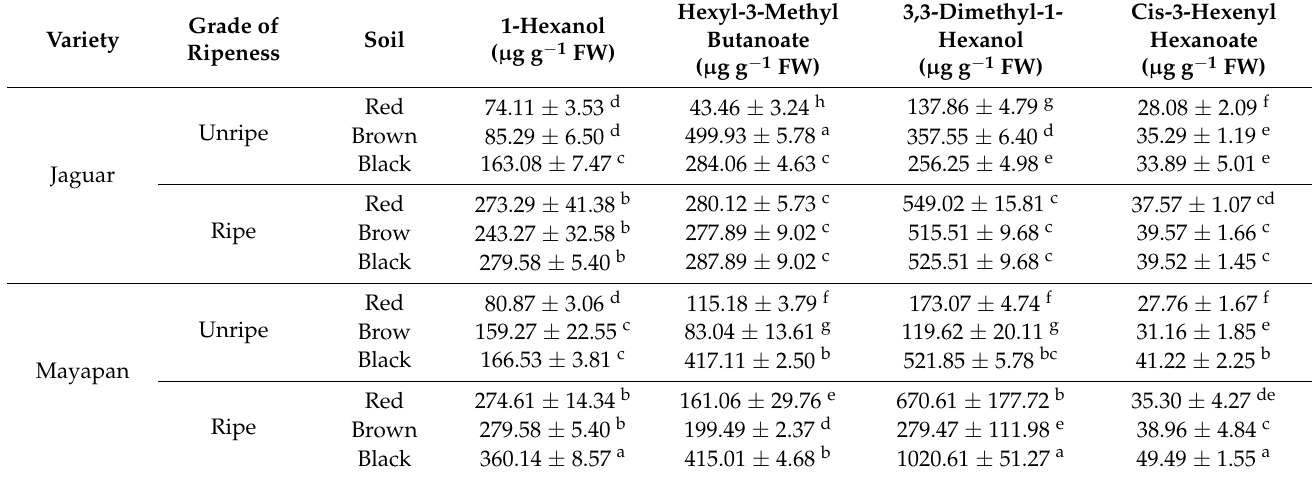
Table 3. Concentration of volatile compounds in ripe and unripe Habanero pepper of two varieties (Jaguar and Mayapan) cultivated in different soils.